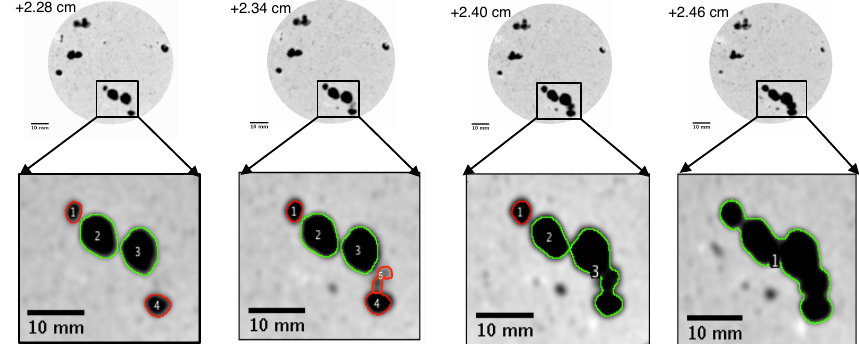
Figure 14. Four successive slices in the snow ice layer on 25 January from + 2.28 to + 2.46cm below the surface. At 2.28cm, four individual bottom end of bubbles exist where at 2.46cm, the top end of each bubbles are joined and formed a single